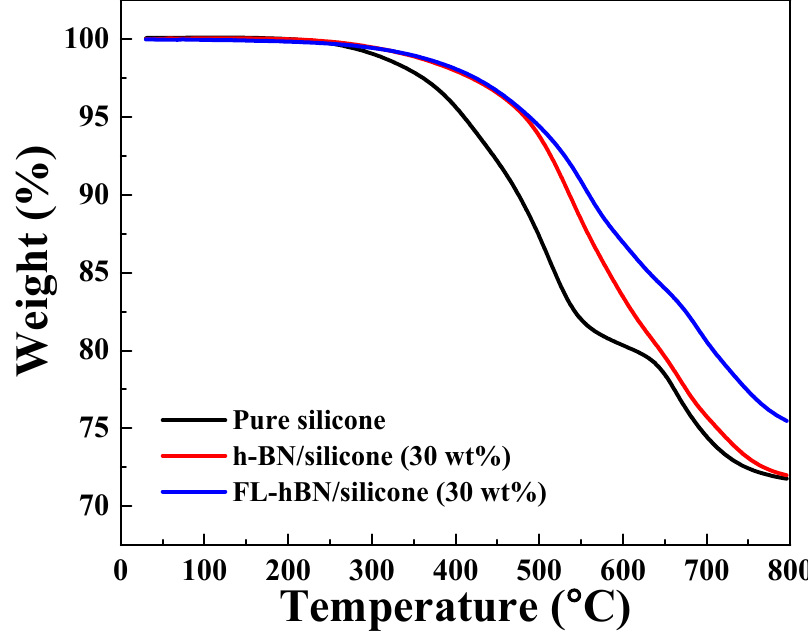
Figure 9. Thermal stabilities of pure silicone, hBN/silicone composites and FL-hBN/silicone.